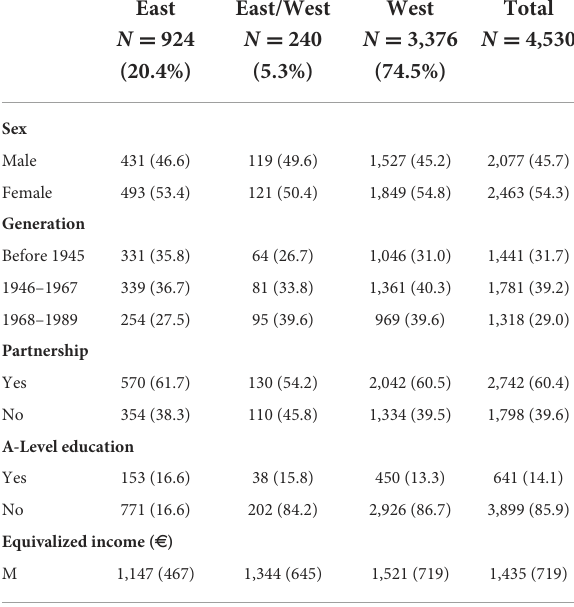
TABLE 1 Sample description by